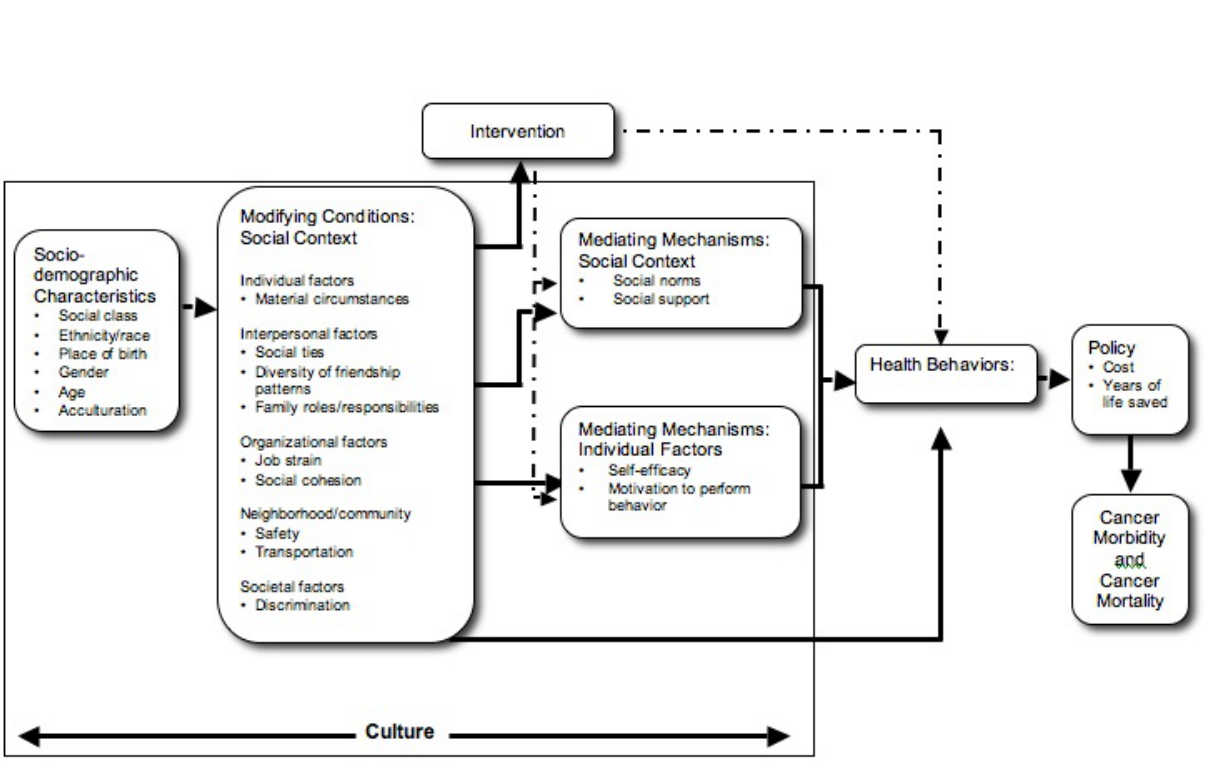
Figure 1. Conceptual